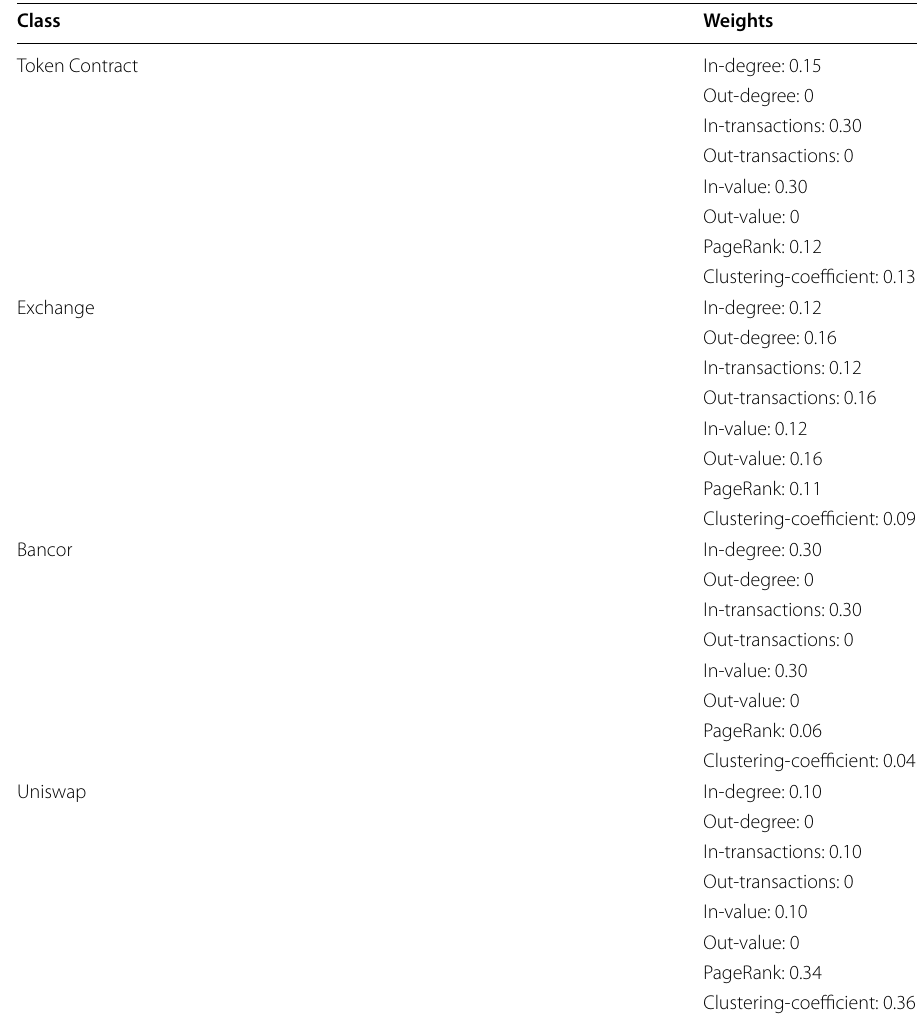
Table 12 The best weight combination for the Eros distance obtained after an exhaustive examination of all the possible combinations on testing data Class Weights Token Contract